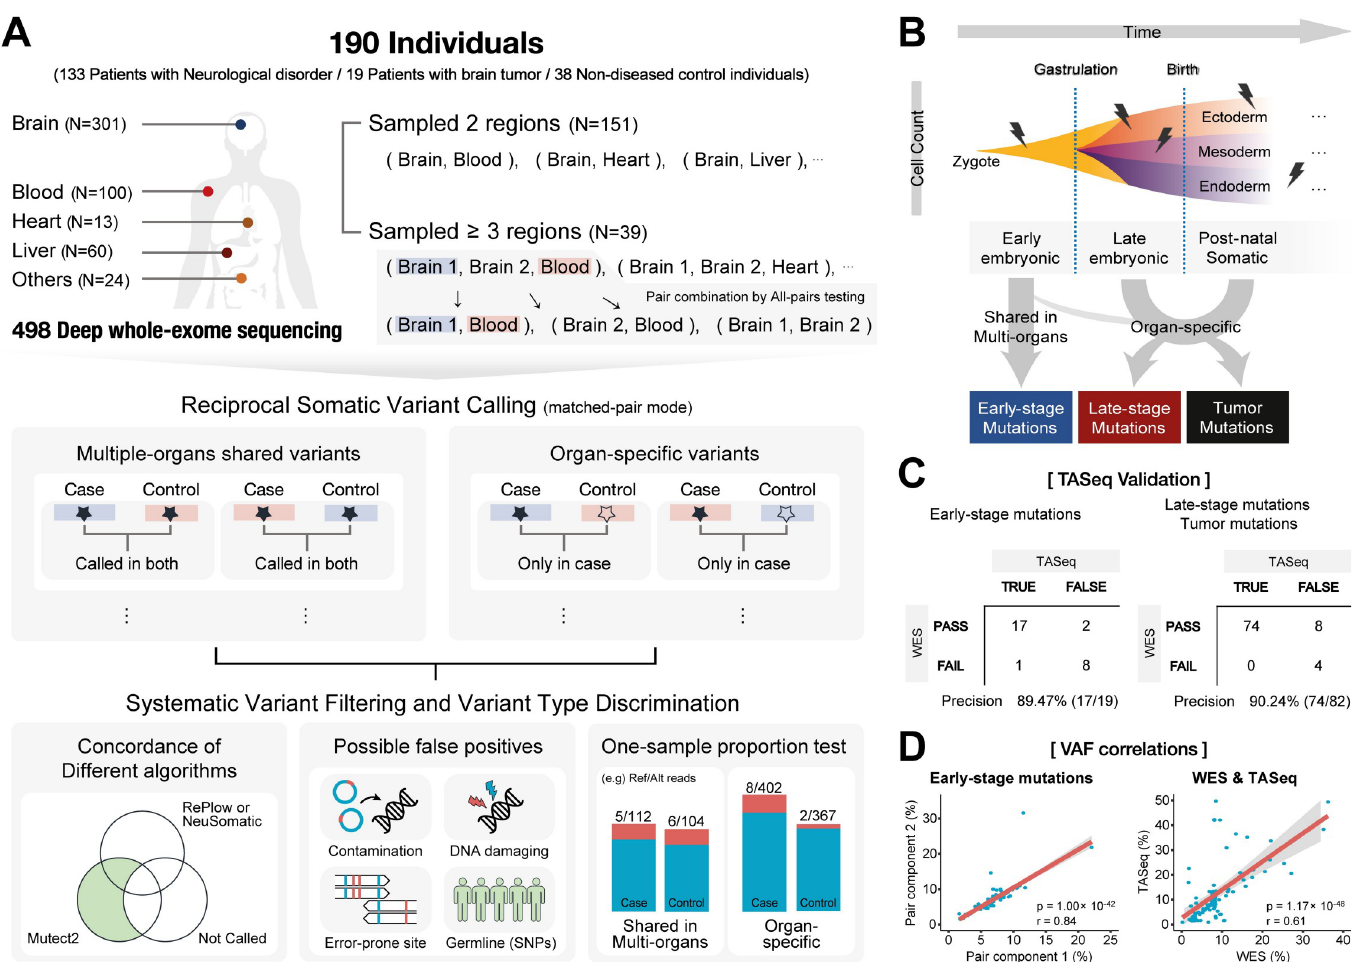
Fig 1. Detection of early and late-stage somatic variants in the brain and matched peripheral tissues. ( A) Schematic flow showing the bioinformatics pipelines for the analysis of 301 brain tissues and 197 peripheral tissues from 190 individuals. Tumor mutations were identified from primary or recurrent tumor specimens, and confirmed by histologic examination. To identify somatic variants, Mutect2 and RePlow/NeuSomatic were used for reciprocal mutation calling by all-pairs testing. First, to detect somatic mutation in tissue “A”, tissues “A” and “B” were used as a case and control, respectively, and tissue “A” was further used as a control to identify somatic mutations in tissue “B”. For tumor tissues, the same analysis was performed as in other samples. Subsequently, post-call filtering was used. After strict filtration and tests for organ specificity using one-sample proportion tests, the shared and organ-specific mutations were classified. The colored bar indicates read distribution, and the red and blue- colored bars indicate the reference and altered reads, respectively (lower right panel). ( B), (C) Early-stage, late-stage, and tumor mutations were classified with a highly accurate precision rate (89.47%, early-stage; and 90.24% in late-stage and tumor mutations). We determined organ specificity using a one-sample proportion test. ( D) Correlation of VAFs from two matched tissues and the WES and TASeq data. VAFs were highly concordant between paired tissues ( r = 0.84; P < 0.0001), and the WES and TASeq data ( r = 0.61; P < 0.0001).